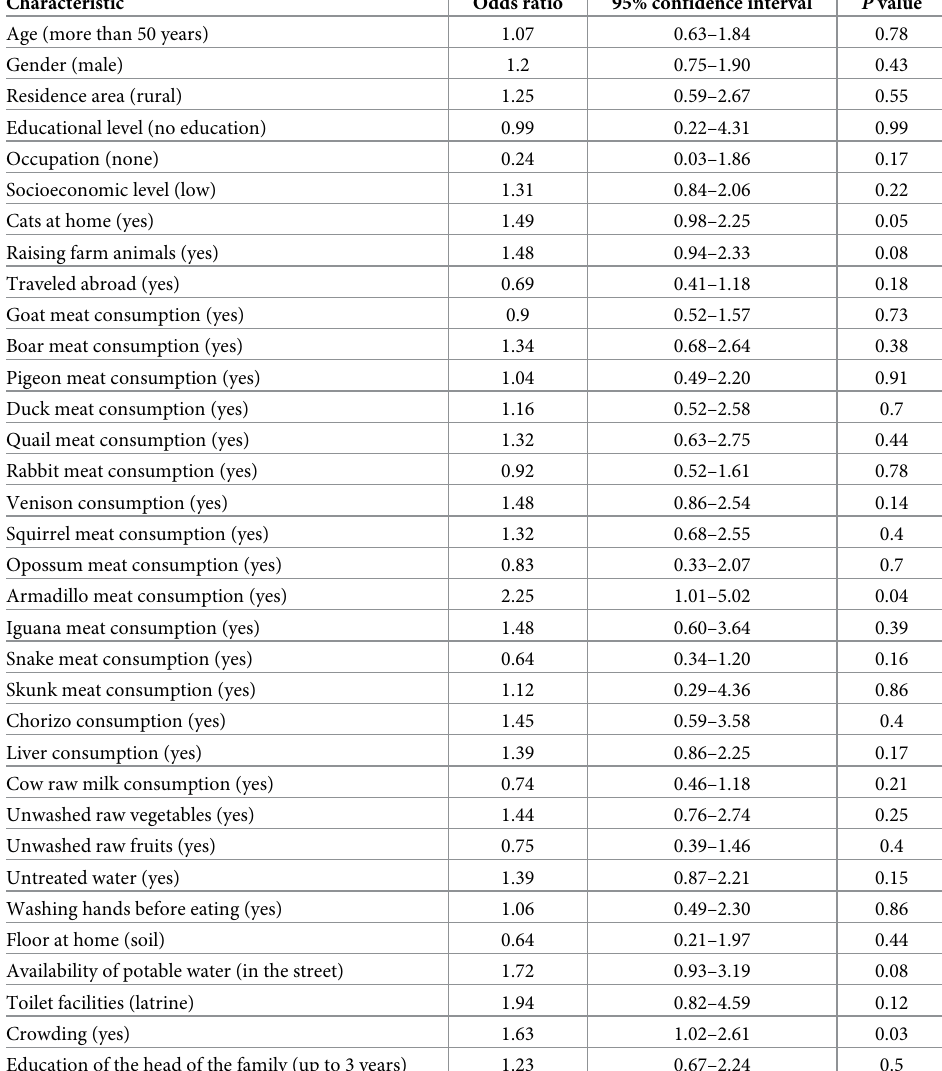
Table 5. Multivariate analysis of selected characteristics of people with alcohol consumption and their association with high ( > 150 IU/ml) anti- T . gondii IgG antibodies. Characteristic Odds